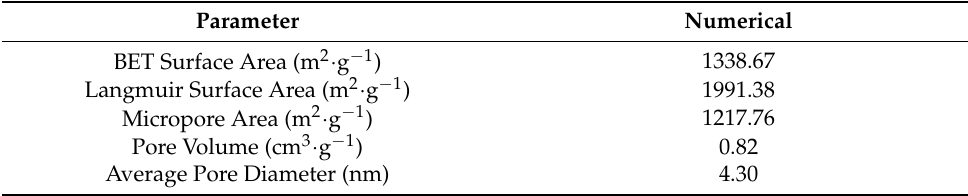
Figure 6. Nitrogen adsorption and desorption isotherms of ZIF-8.